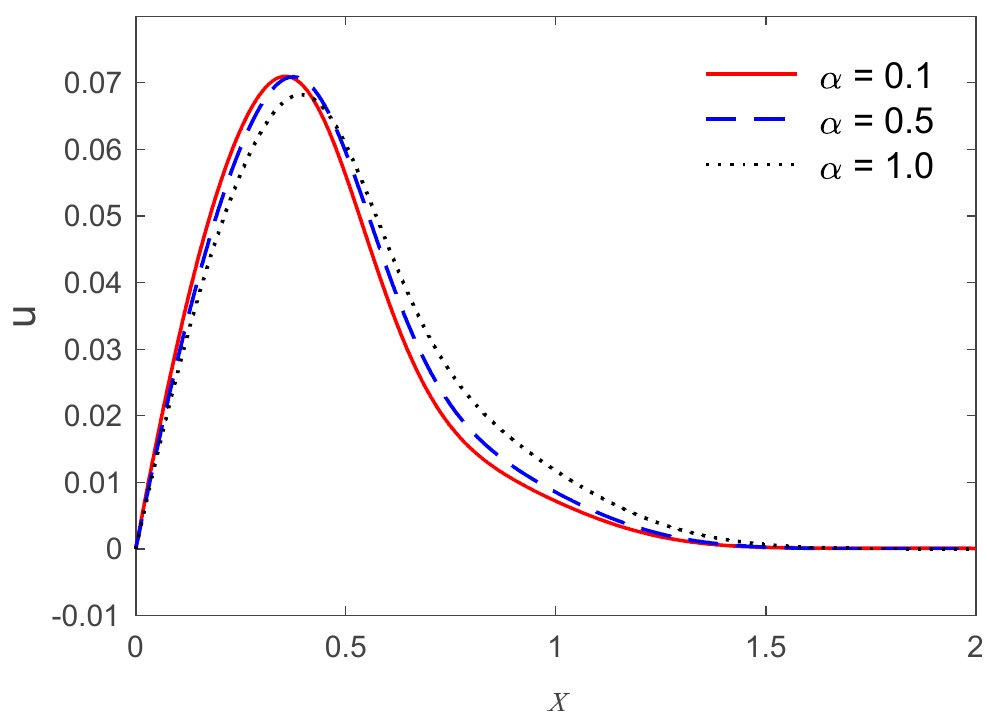
Figure 4. The solid displacement distributions 𝑢 via 𝑥 for three values of fractional parameter.